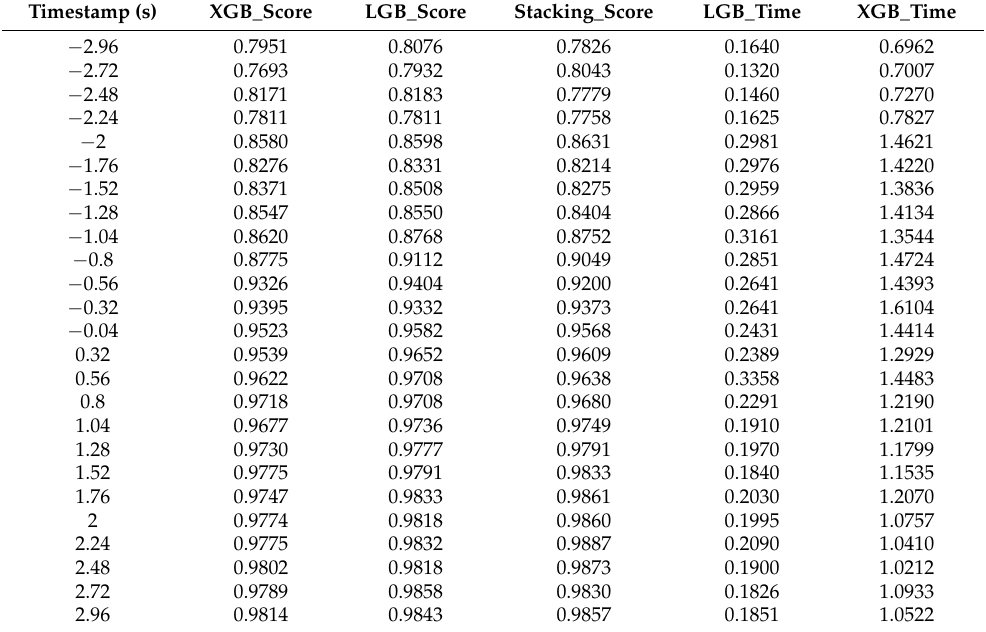
Table 9. Comparison of lane-changing intention recognition accuracy at different